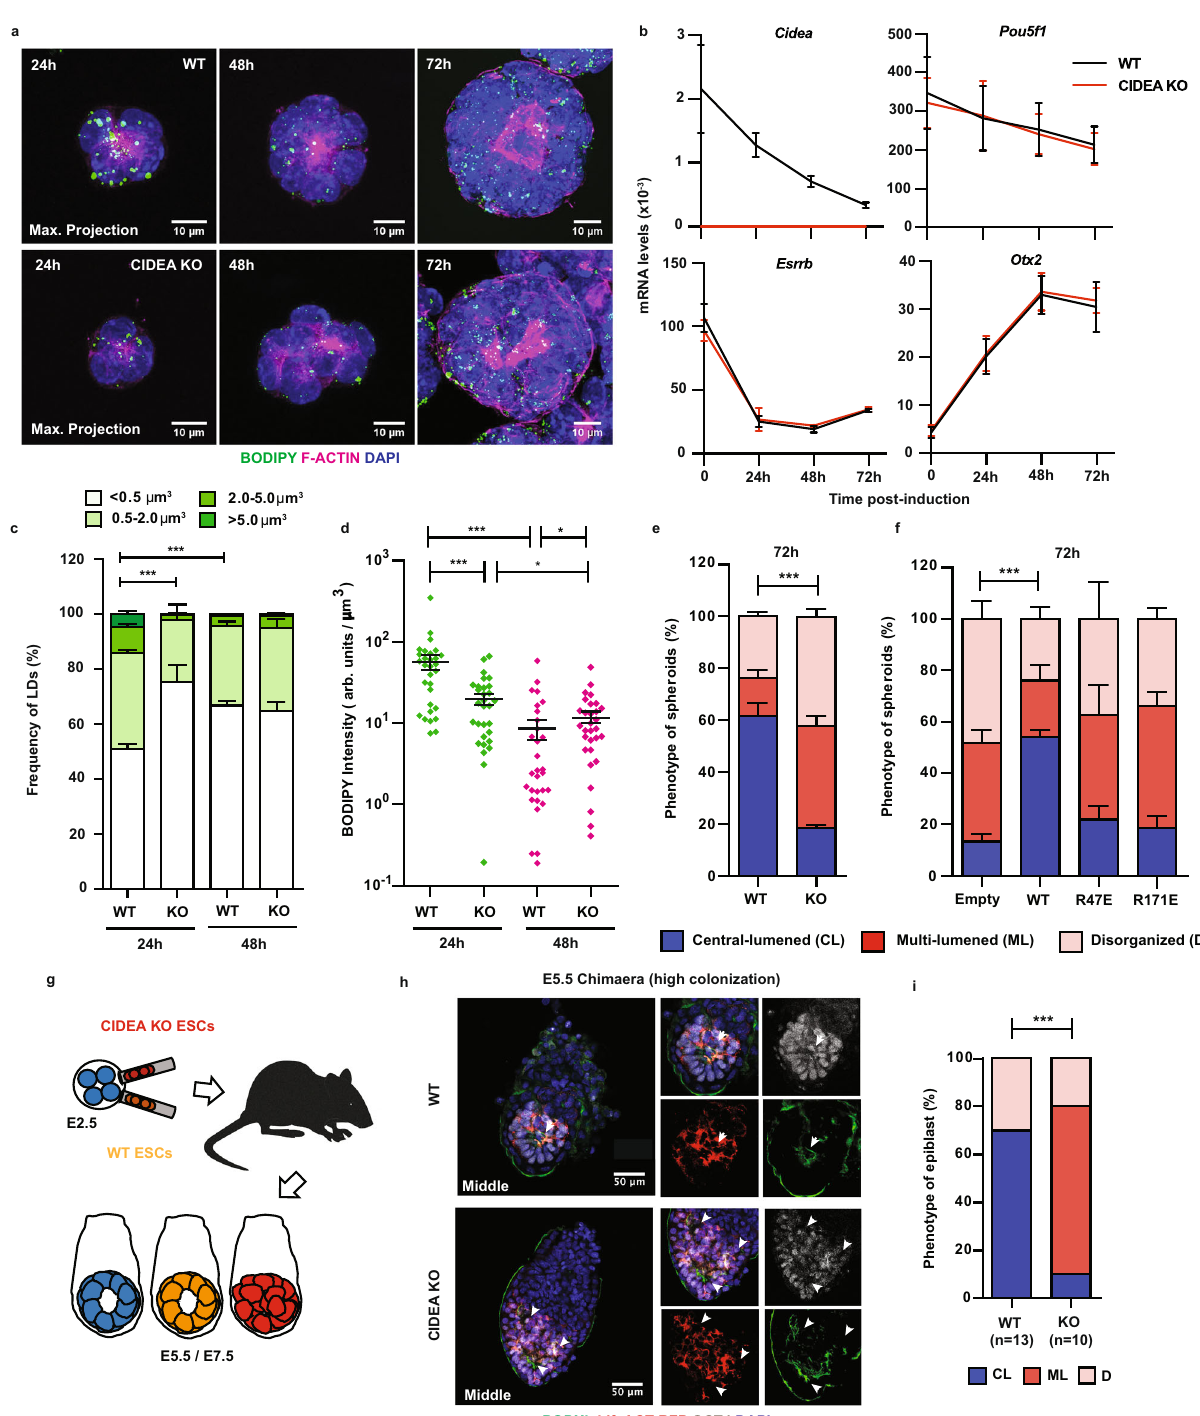
Fig. 6d – f) 34,38 . In contrast, BODIPY-labelled LDs did not accu- mulate apically in polarised KO spheroids, but instead were rapidly lost during the short time-course of our imaging experi- ment (~2 h; Fig. 4a, right panel; Supplementary Movie 6). High turn-over rate of LDs suggests that promiscuous degradation may operate in the absence of CIDEA-mediated LD enlargement, subsequent differentiation (Fig. 4d, e). Together, our results concurring with the reduced levels of stored lipids we detected in indicate a key role for CIDEA-promoted LD fusion in protecting CIDEA KO spheroids (24 h; Fig. 3d and Supplementary Fig. 5a). NATURE COMMUNICATIONS| (2022) 13:3861